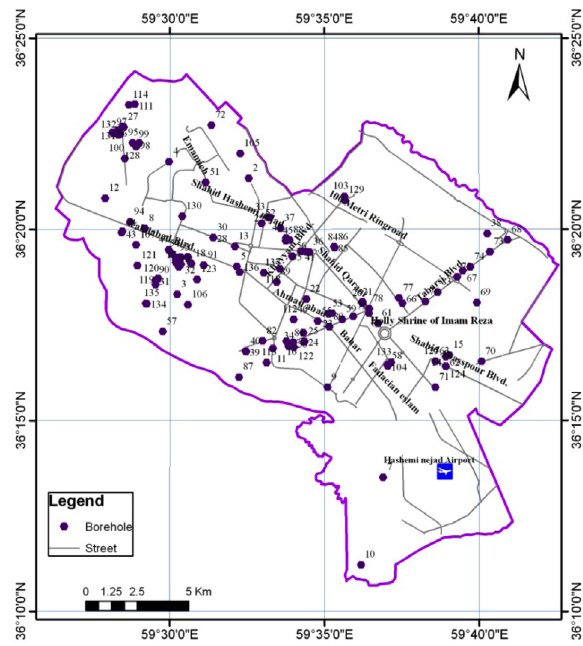
Figure 3. Location of geotechnical boreholes.